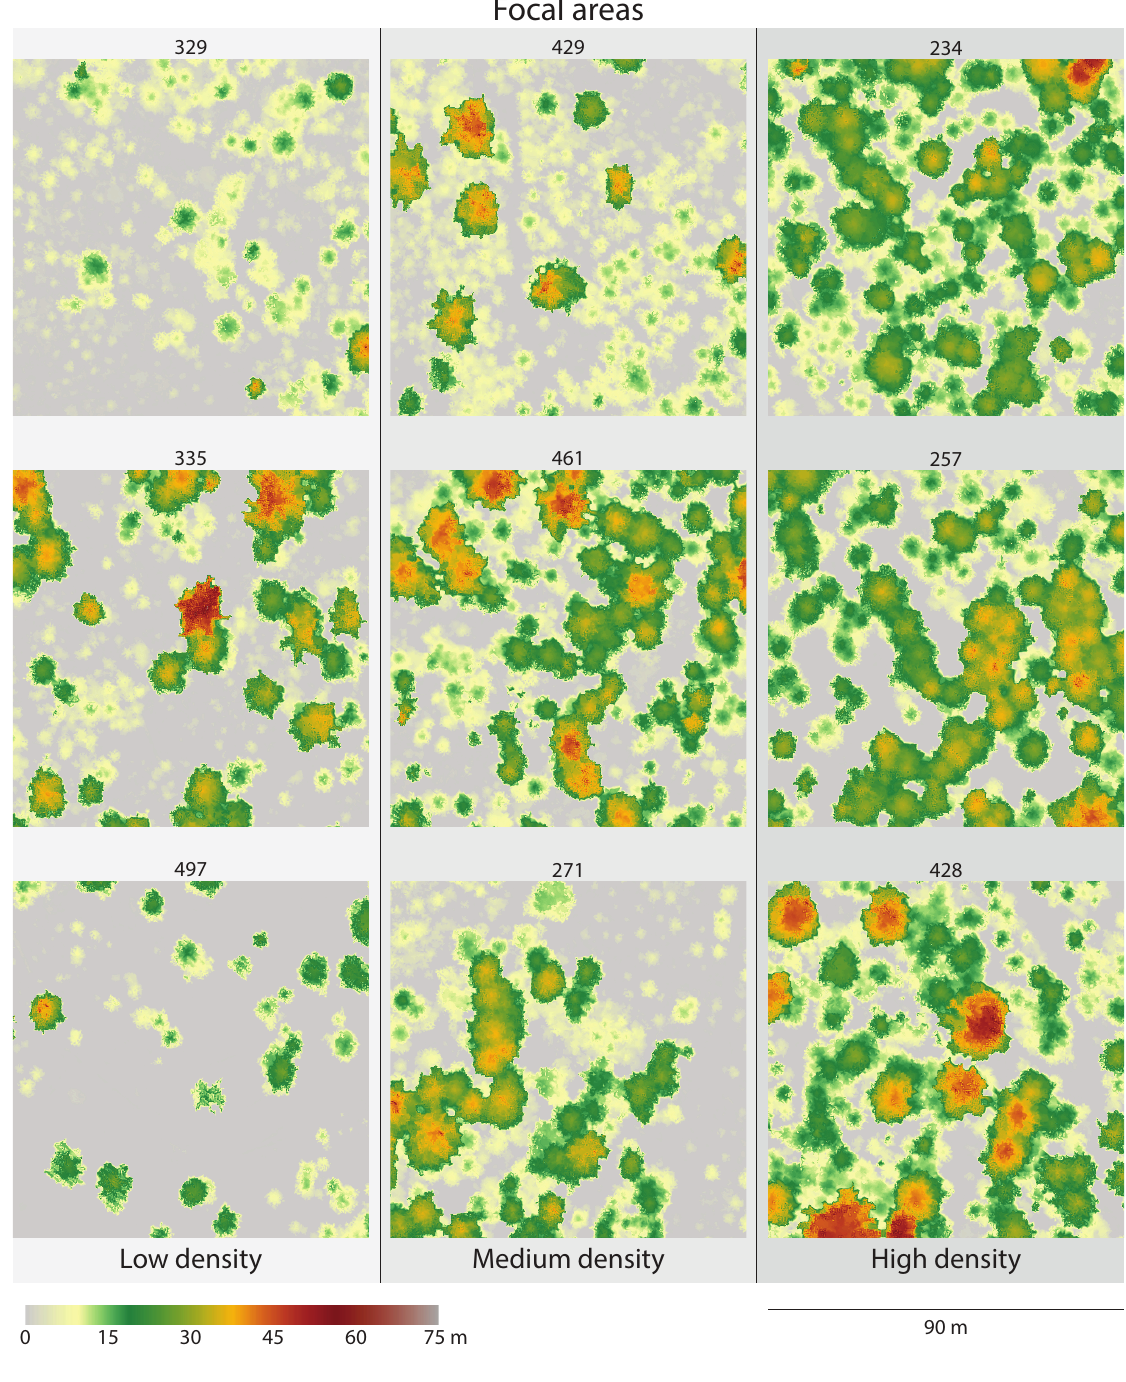
Figure 3. Nine 90 × 90 m square focal areas were segmented using the lidar-derived and OBIA-derived methods. The areas varied across tree density, from low ( left column), medium ( middle column), to high ( right column). The color above corresponds to corrected CHM height